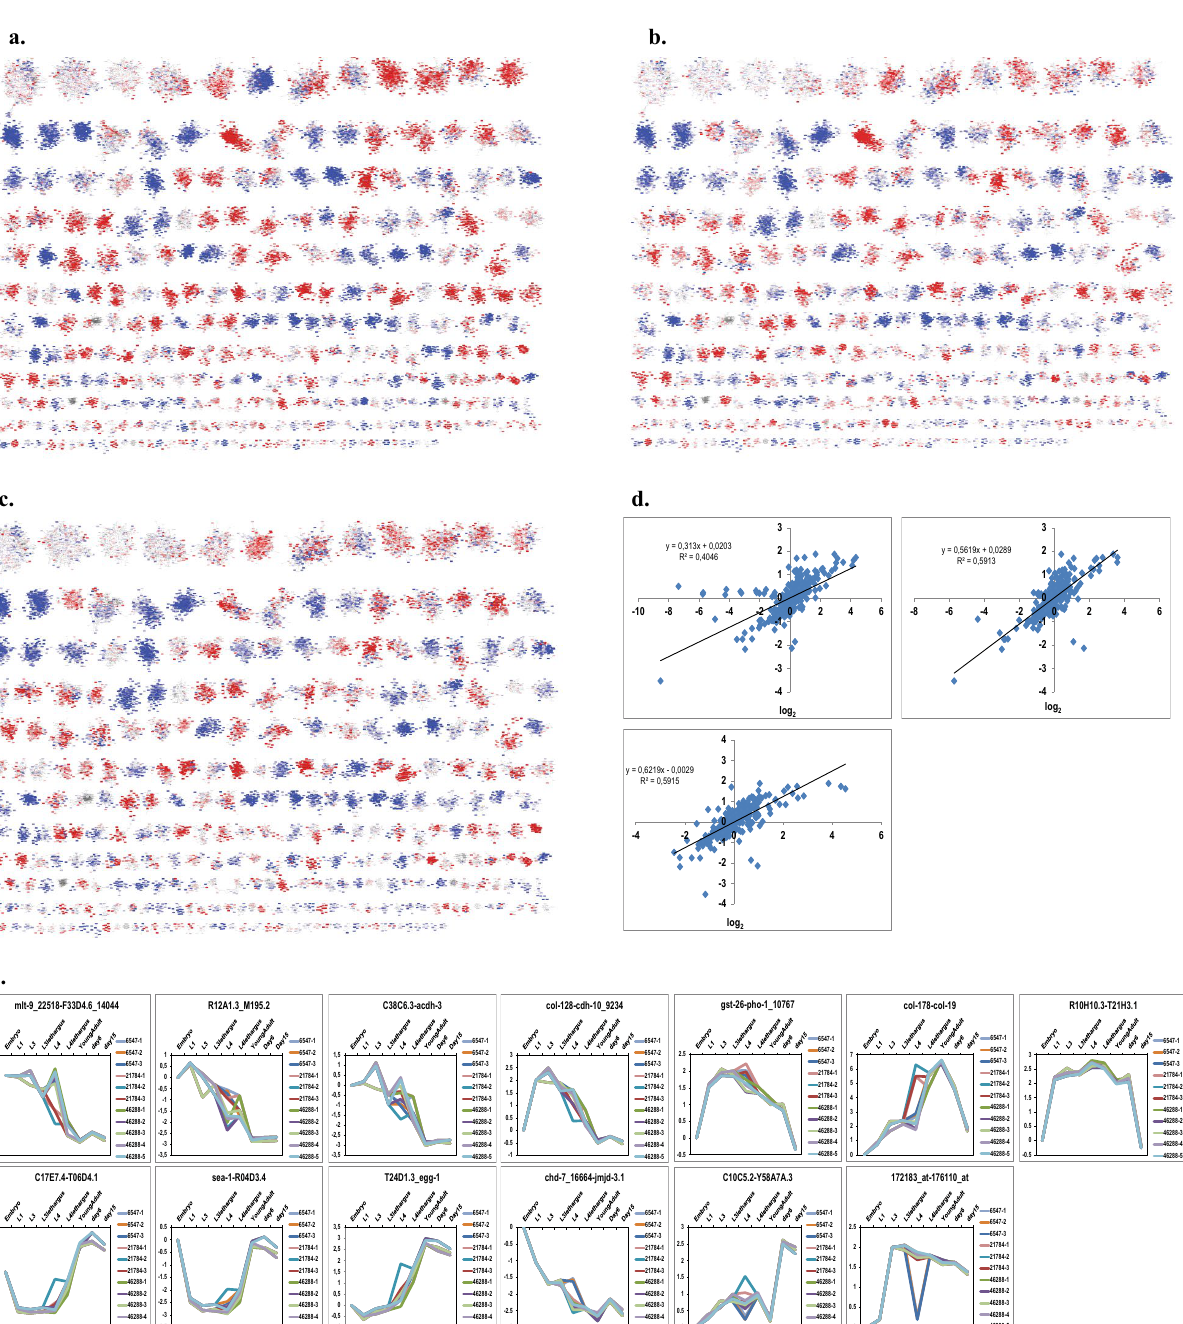
Figure 3. Expression in developmental stages is altered in similarity to the RNAi-induced arrest. ( a ) L3 comparison to young adult. ( b ) L4 comparison to young adult and ( c ) L4 lethargus to young adult. Other stepwise comparisons, like that of embryo to L1 or that of day6 nematode to day 16 adult nemtode are shown in the Supplemental Figures section as Supplemental Fig. 3, 4, 5 and 6. ( d ) Clique responses throughout development shown for selected cliques with significant change pattern. Cliques colored in red are induced compared to the earlier developmental stage, while cliques colored in blue are repressed. The linear regression function was generated with Microsoft Excel without weighting, a square value of 1 would indicate a perfect correlation between the